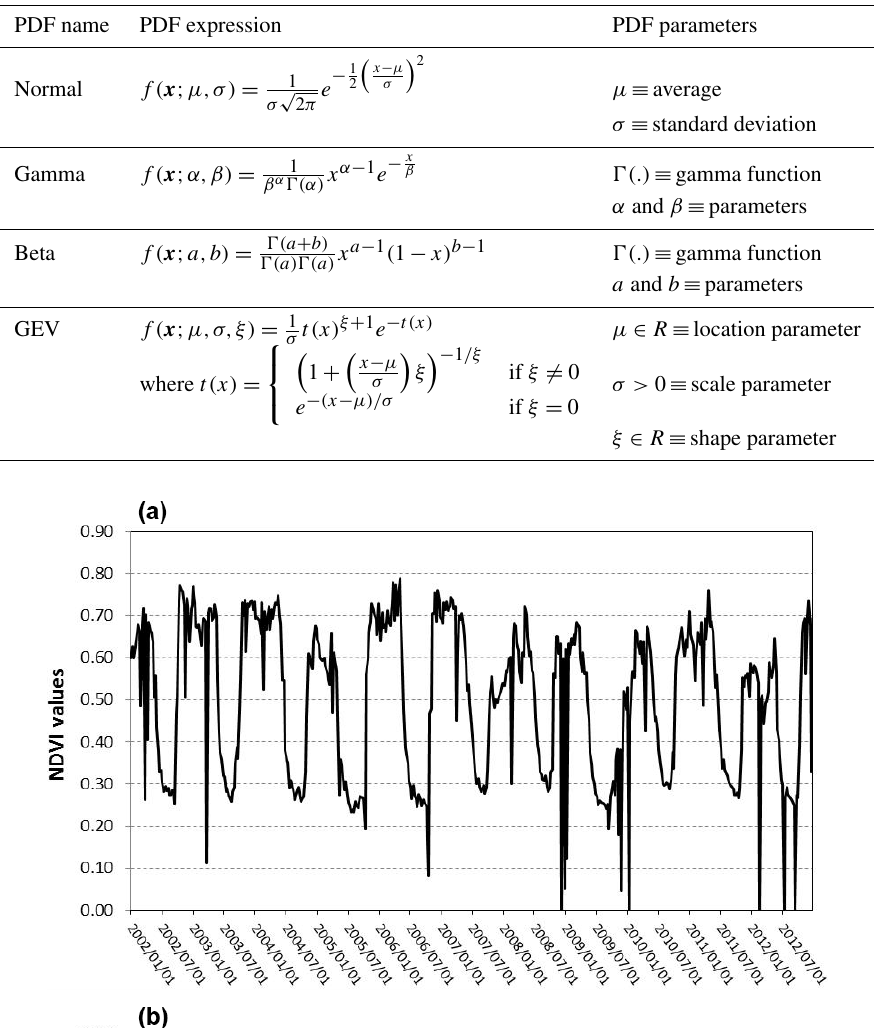
Table 2. Candidate probability density functions (PDFs).